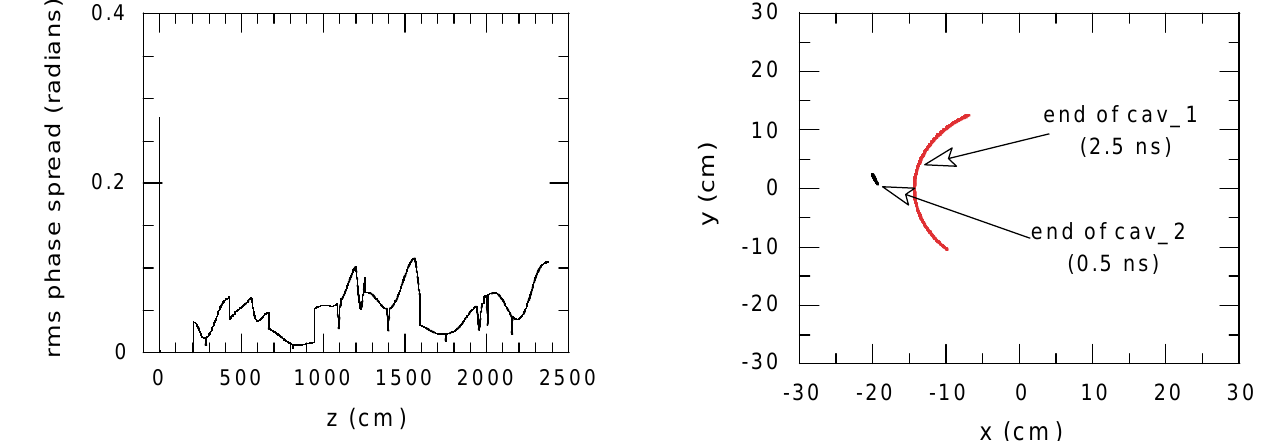
FIG. 6. (Color) Transverse portrait of the loci of 400 compu- tational particles in the planes z (cid:1) 206 cm (end of first cav- ity) and z (cid:1) 429 cm (end of second cavity). All the particles arrive at the end of the first cavity during a time interval of 2.5 nsec and at the end of the second cavity during a time in- terval of 0.5 nsec, showing a reduction by a factor of (cid:8) 13 in the bunch length and a reduction of a factor of 5 in the arrival